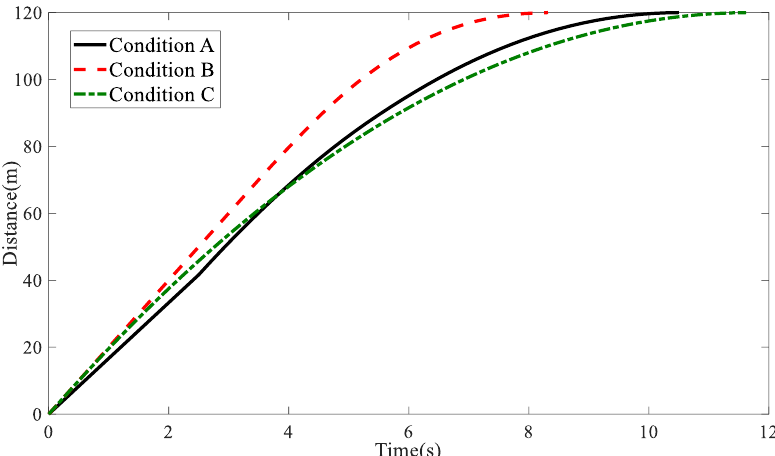
Figure 18. Driving distance with time under different conditions.